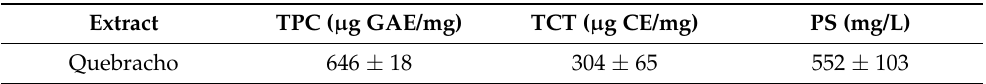
Table 1. Total phenolic content, total condensed tannins, antioxidant capacity, and polysaccharide fraction of quebracho Fintan 737 industrial tannin extract.